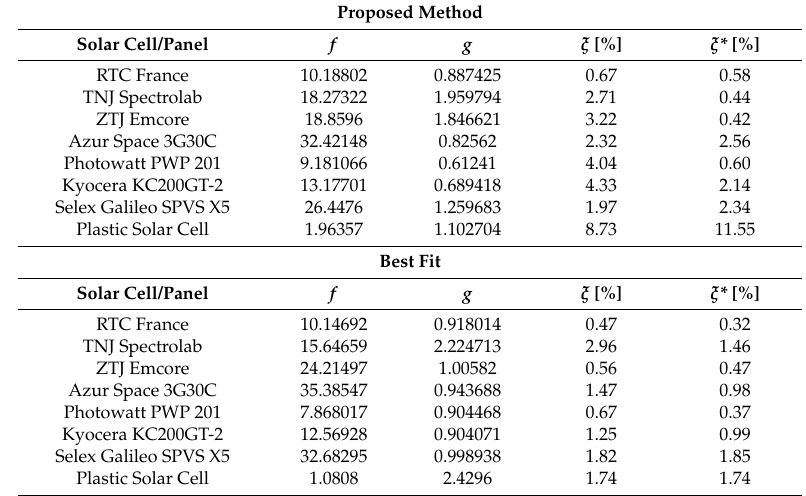
Table 6. Parameters from Das/Saetre’s explicit model (Equation (25)), fitted to the I – V curves for the photovoltaic devices studied (see Table 1). The fittings were performed numerically (best fit), and using the proposed method (Equation (29)). The normalized RMSE values of the fittings, ξ , and ξ * , are included in the